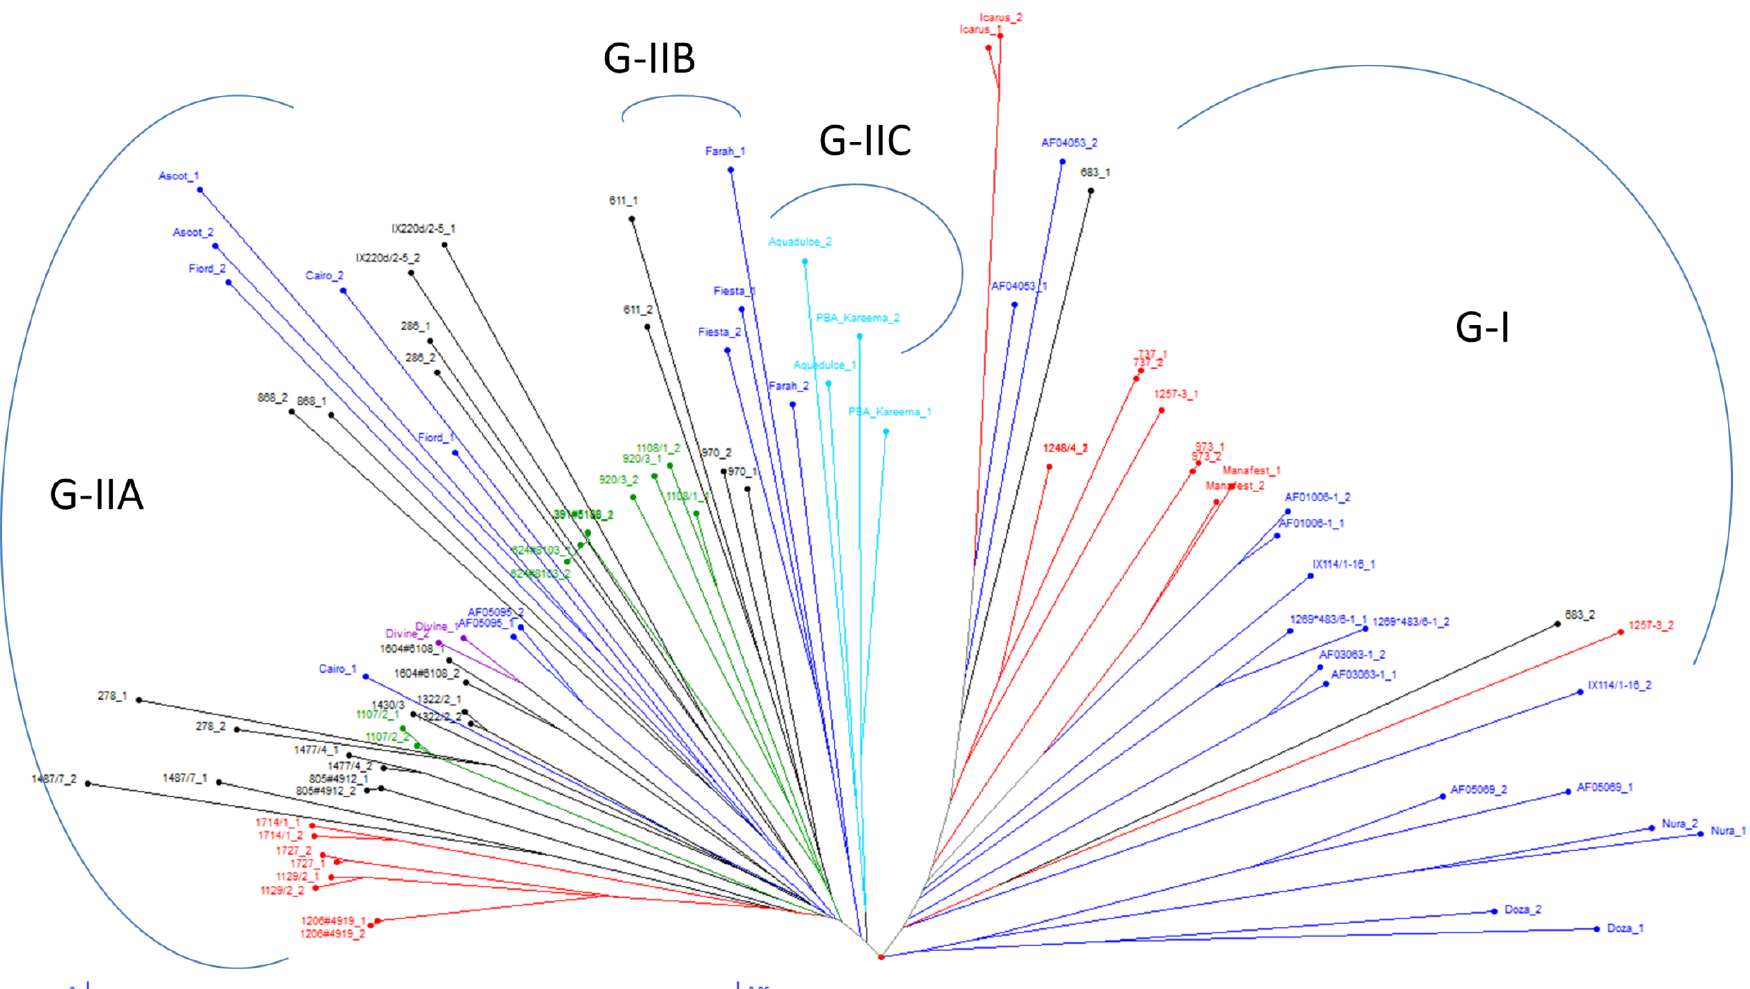
Figure 1. Unweighted pair group method with arithmetic average (UPGMA) neighbour-joining (NJ) dendrogram generated based on genetic distance calculations from NTSYS v2.1. Group-I (Ecuador (red), Australia (blue), ICARDA breeding program (black)), Group-II-A (China (red), North Africa (green), Australia (blue) and Europe (purple), Group-II-B (Australia (blue)) and Group-II-C (Australia (light